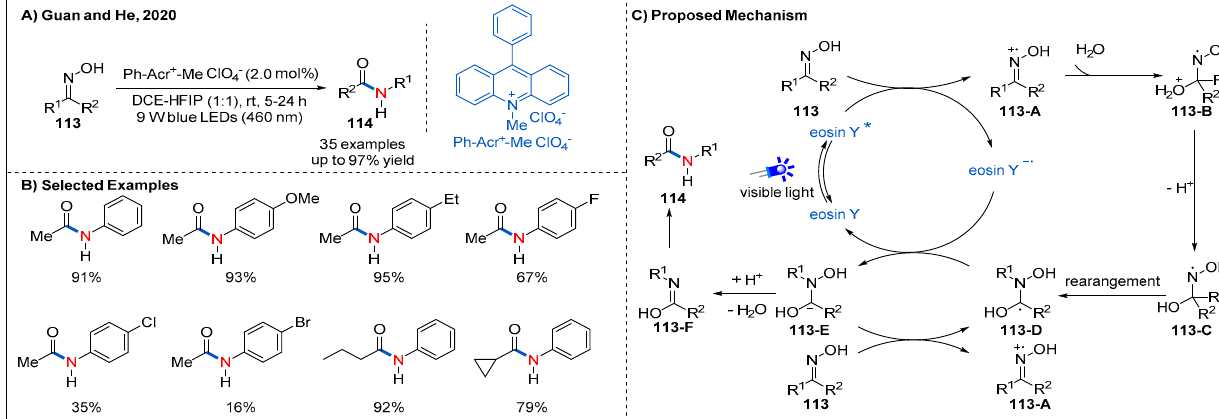
Figure 34. Visible-light-driven photoredox-catalyzed Beckmann rearrangement.